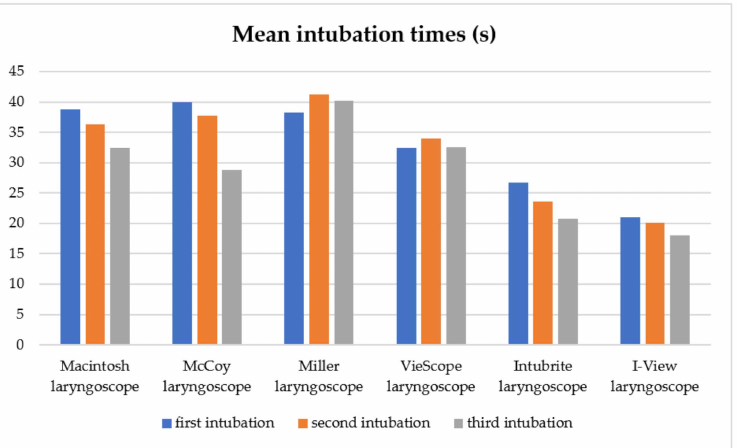
Figure 4. Graph of mean intubation times with a given laryngoscope in subsequent intubation attempts.